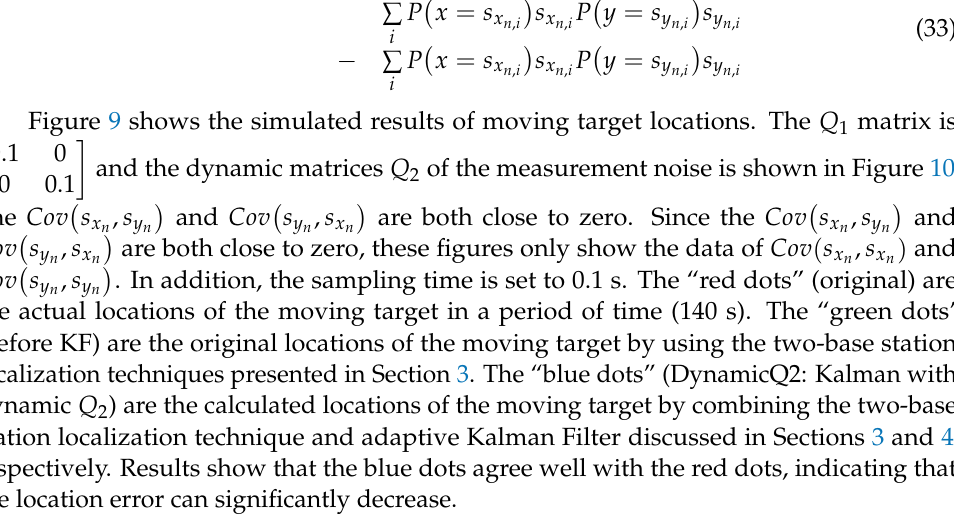
(cid:0) (cid:1) x = s x and P (cid:4667) and 𝑃(cid:4666)𝑦 = 𝑠 (cid:3052) n , i (cid:3289),(cid:3284)